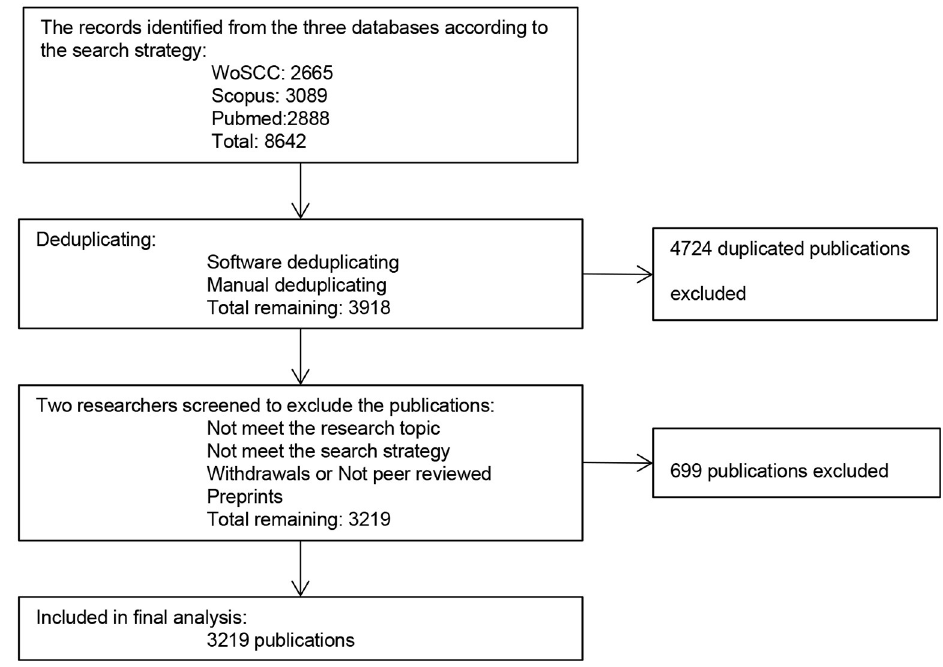
Fig 1. Flow chart of LKB1 researches